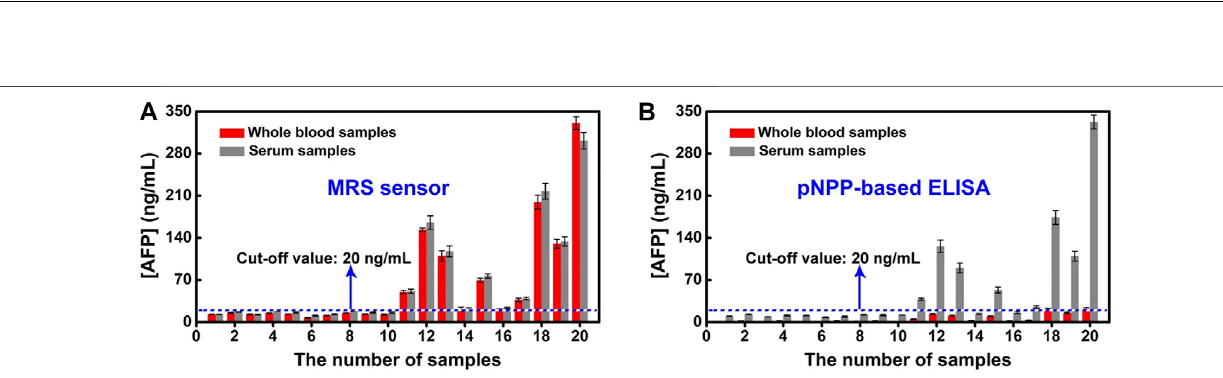
Frontiers in Chemistry |